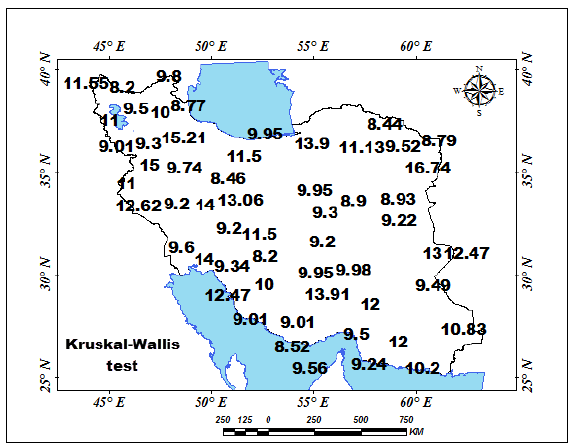
Figure 8. Values of Kruskal-Wallis test.